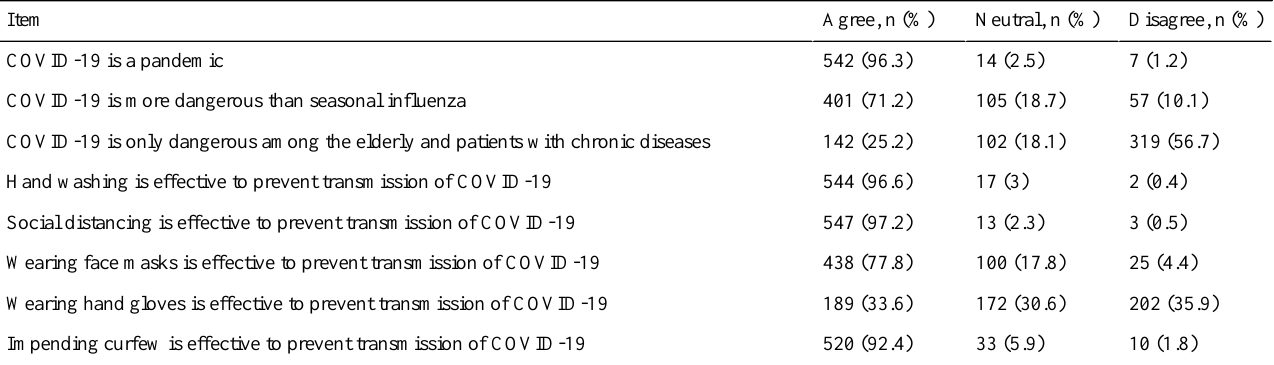
Table 2. Levels of knowledge of COVID-19 among health care workers in Saudi Arabia (N=563).